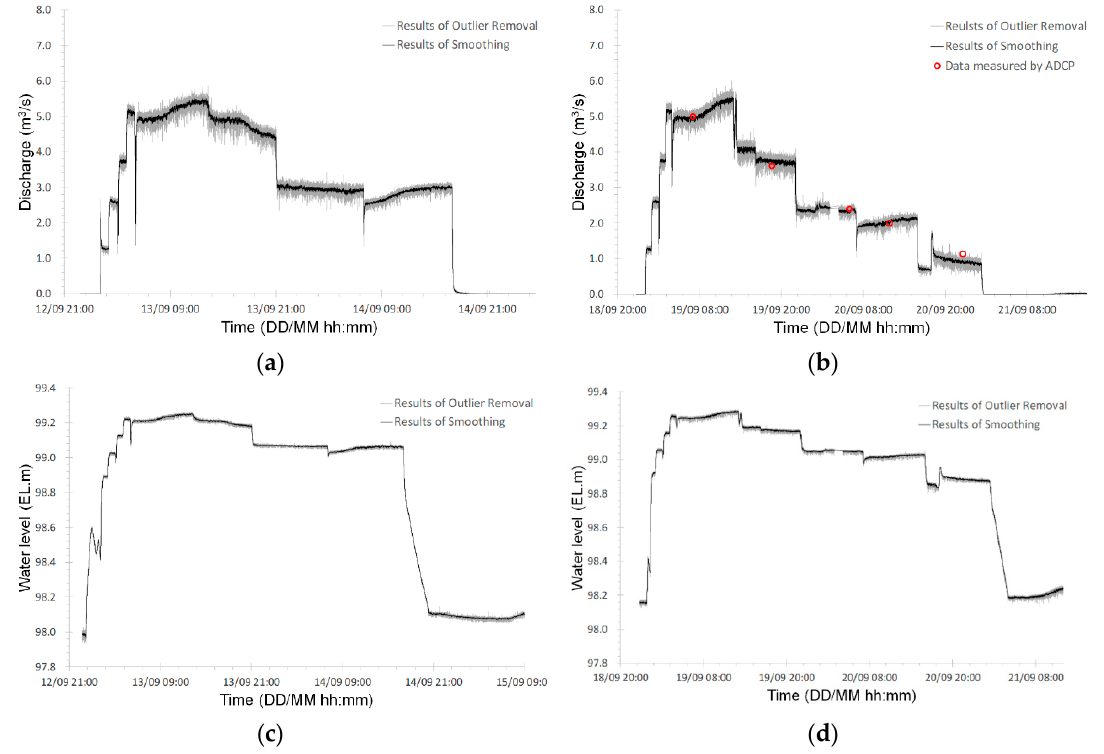
Figure 10. Flow discharge in the upstream weir and water level in the downstream bridge monitored by ultrasonic sensors. ( a ) Flow discharge converted by water level data in case of hydrograph 1—upstream weir; ( b ) flow discharge converted by water level data in case of hydrograph 2—upstream weir; ( c ) water level converted by measured data in case of hydrograph 1—downstream bridge; ( d ) water level converted by measured data in case of hydrograph 2—downstream bridge. Water 2019 , 11 , x FOR PEER REVIEW